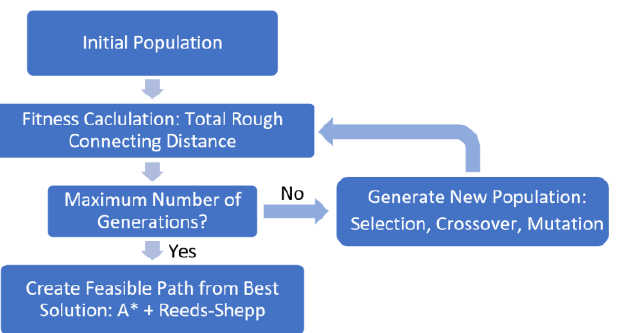
Figure 15. GA procedure to find the optimal subfield connecting path. 372 Figure 16. GA procedure to find the optimal subfield connecting